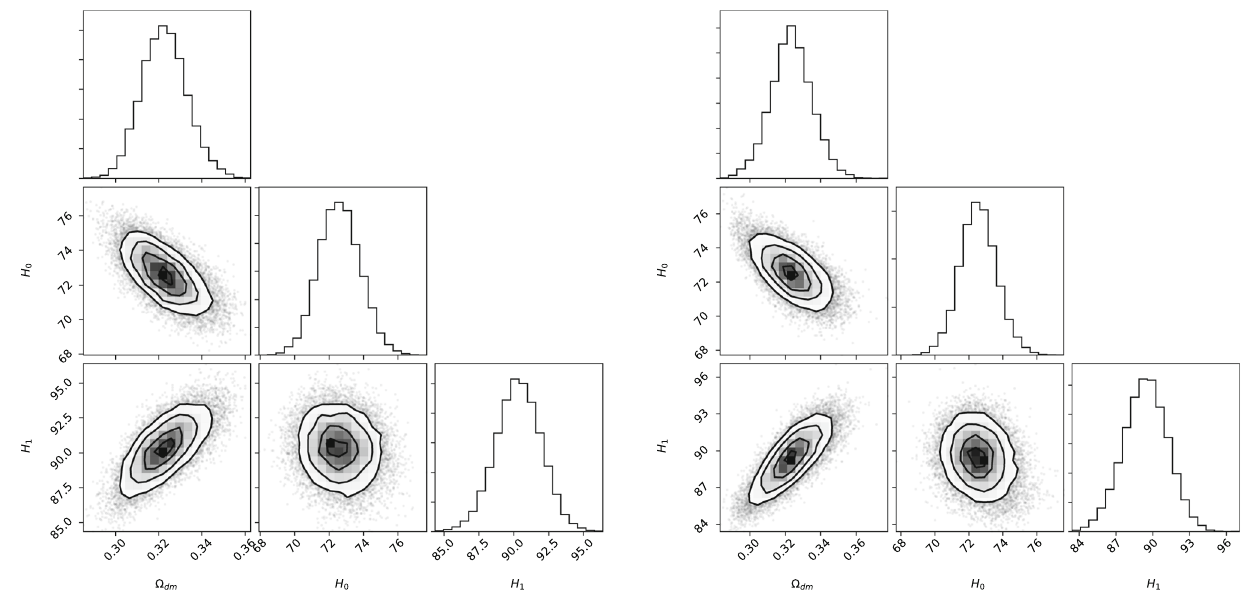
Fig. 1 ThecontourmapofthemodelgivenbyEq.(14),for z ∈ [ 0 , 2 . 5 ] , is given on the left hand side plot. The one on the right hand side depicts the contour map of the same model for z ∈ [ 0 , 5 ] . The best fit values of the model parameters are (cid:8) dm = 0 . 322 ± 0 . 01, H 0 = 72 . 59 ± 1 . 21 km/s/Mpc and H 1 = 90 . 34 ± 1 . 61 km/s/Mpc for z ∈ [ 0 , 2 . 5 ] . For z ∈ [ 0 , 5 ] , they are found to be (cid:8) dm = 0 . 325 ± 0 . 012,